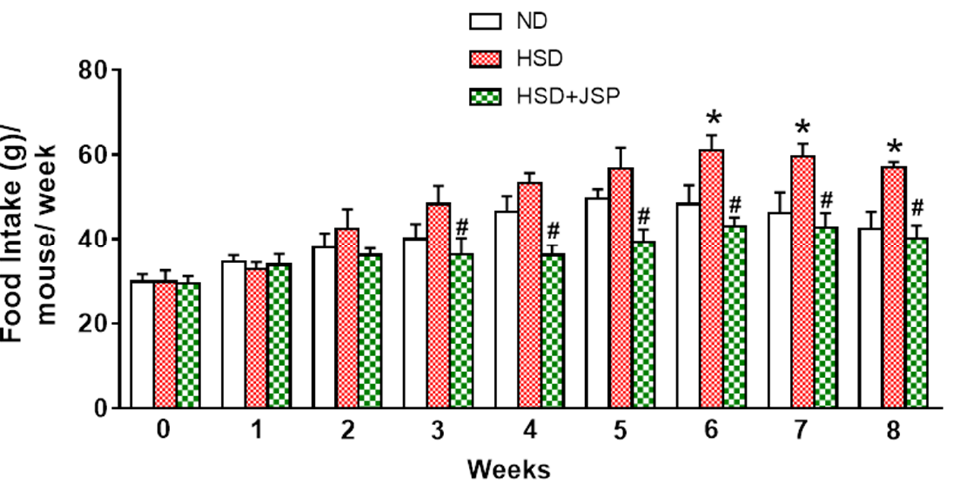
Figure 1. JSP supplementation attenuated HSD-induced hyperphagia. ND: Normal Diet; HSD: High-Sugar Diet; and JSP: Jackfruit Seed Powder. * p < 0.05 vs. ND; # p < 0.05 vs. HSD by one-way ANOVA followed by Tukey’s post hoc test. Bars represent mean ± SEM. n ≥ 3 for each group.